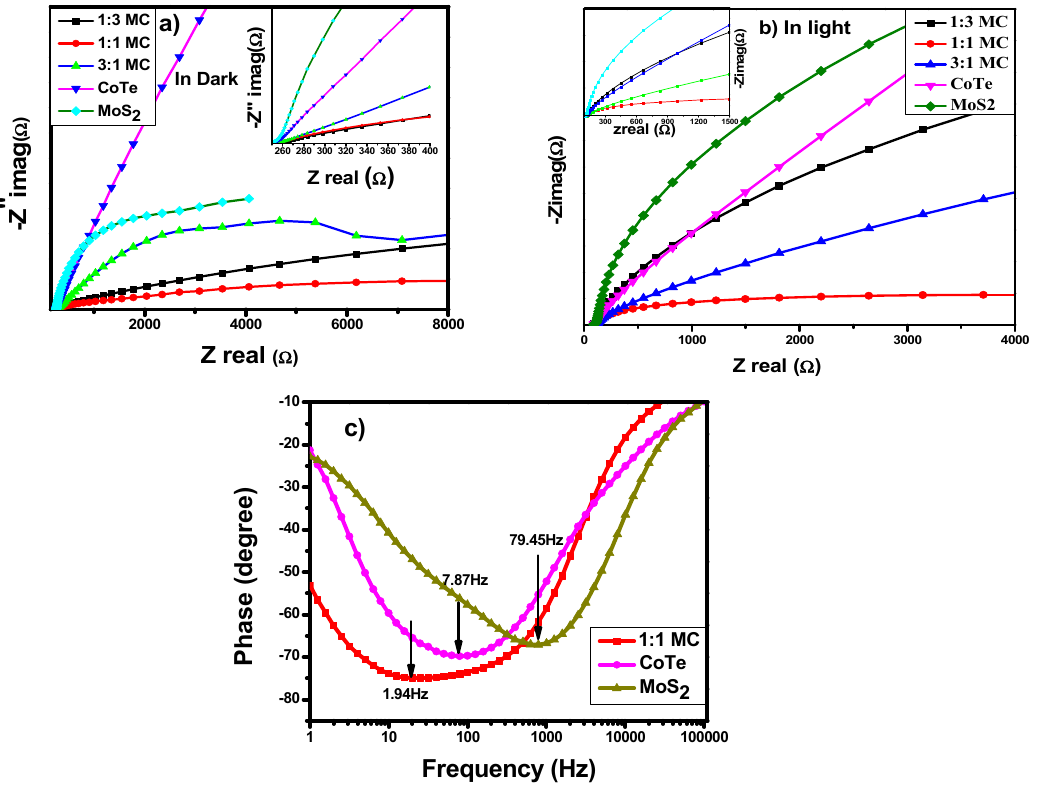
Figure 7. ( a ) Nyquist plot of the pure and composites in dark, ( b ) Nyquist plot of pure and composites in light and ( c ) Bode plot.